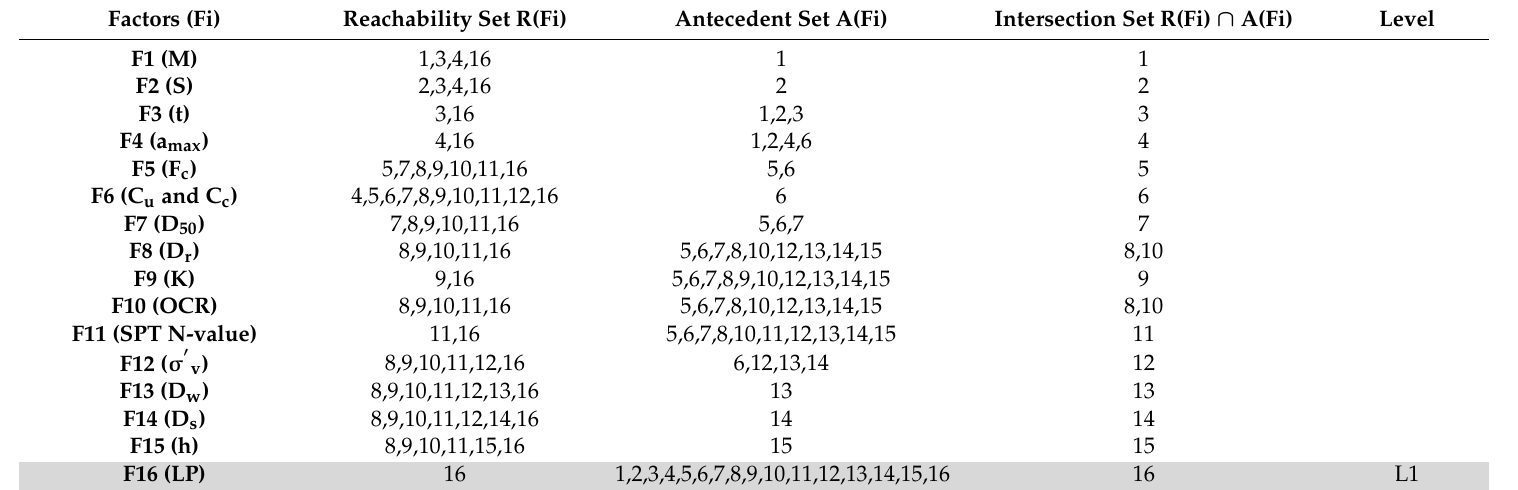
Table A3. Level partition—Iteration